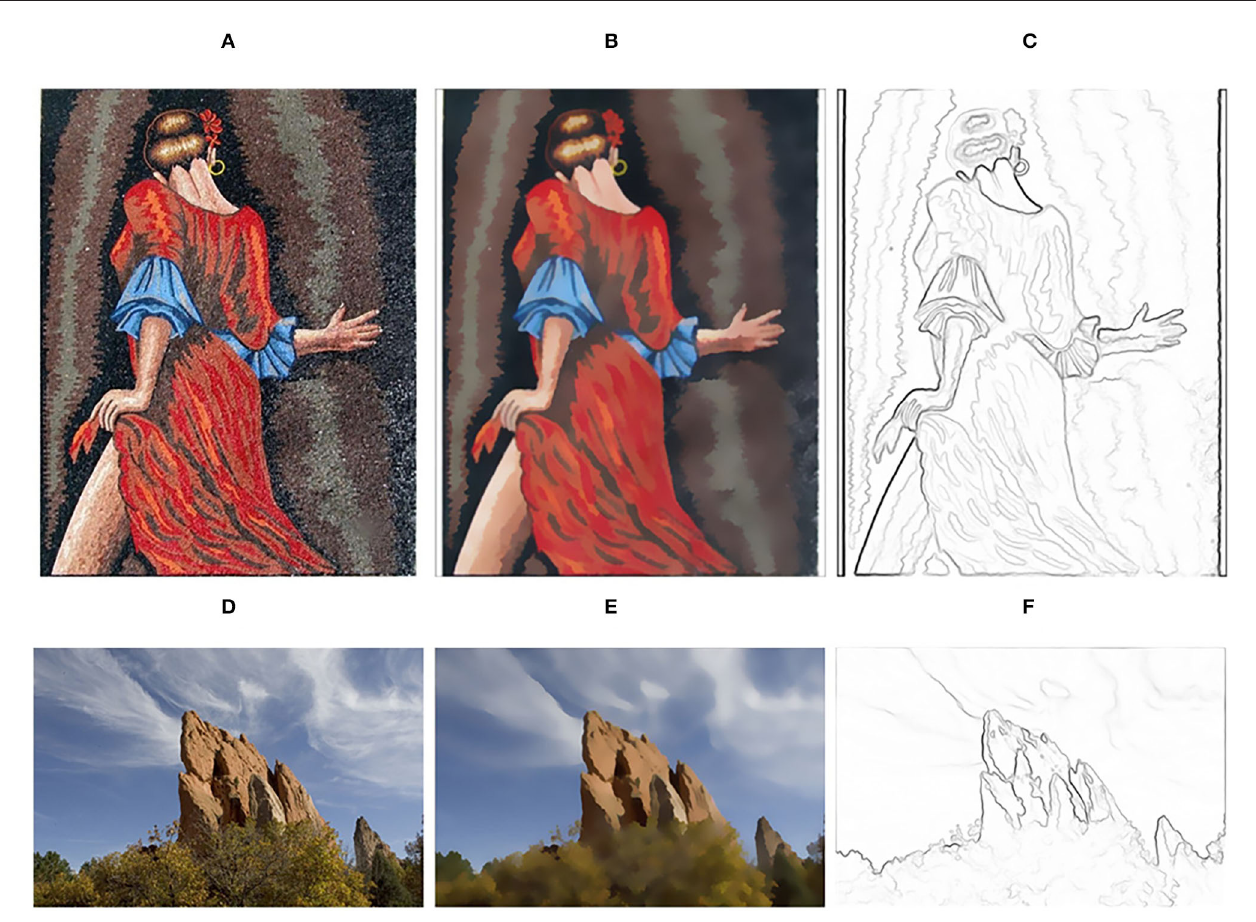
FIGURE 12 | Image abstraction and Pencil sketching. (A,D) Input images; (B,E) Image abstraction results; (C,F) Pencil sketching results. Panel (A) is reproduced with permission from JiaXianYao, available at https://github.com/JiaXianYao/Bilateral-Texture-Filtering. Panel (D) is reproduced with permission from By Sylvain Paris, Samuel W. Hasinoff and Jan Kautz, available at